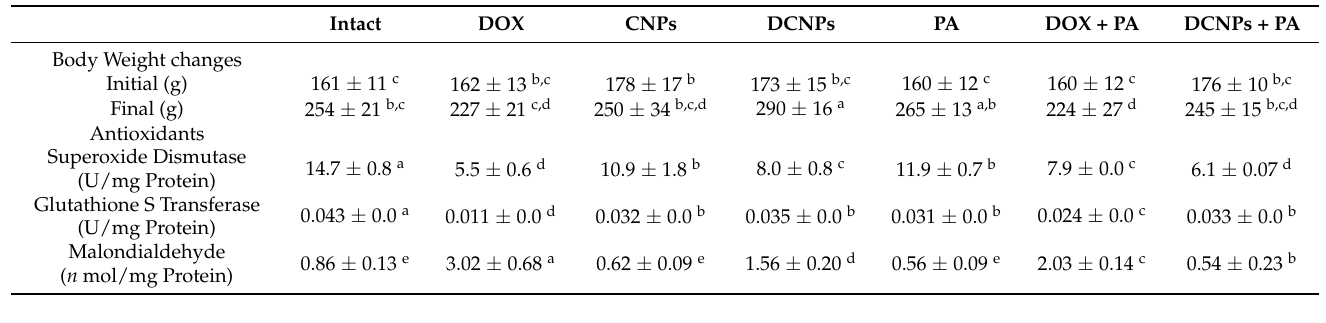
Table 1. The effect of CNPs, PA and DCNPs on Body Weight, Heart Weight, Heart Beat and the level of antioxidants in Heart tissues of experimental animals. Values were expressed as mean ± SD ( n = 5). Values with different alphabets are significantly different from each other, and values with same alphabets have insignificant changes ( p < 0.05).